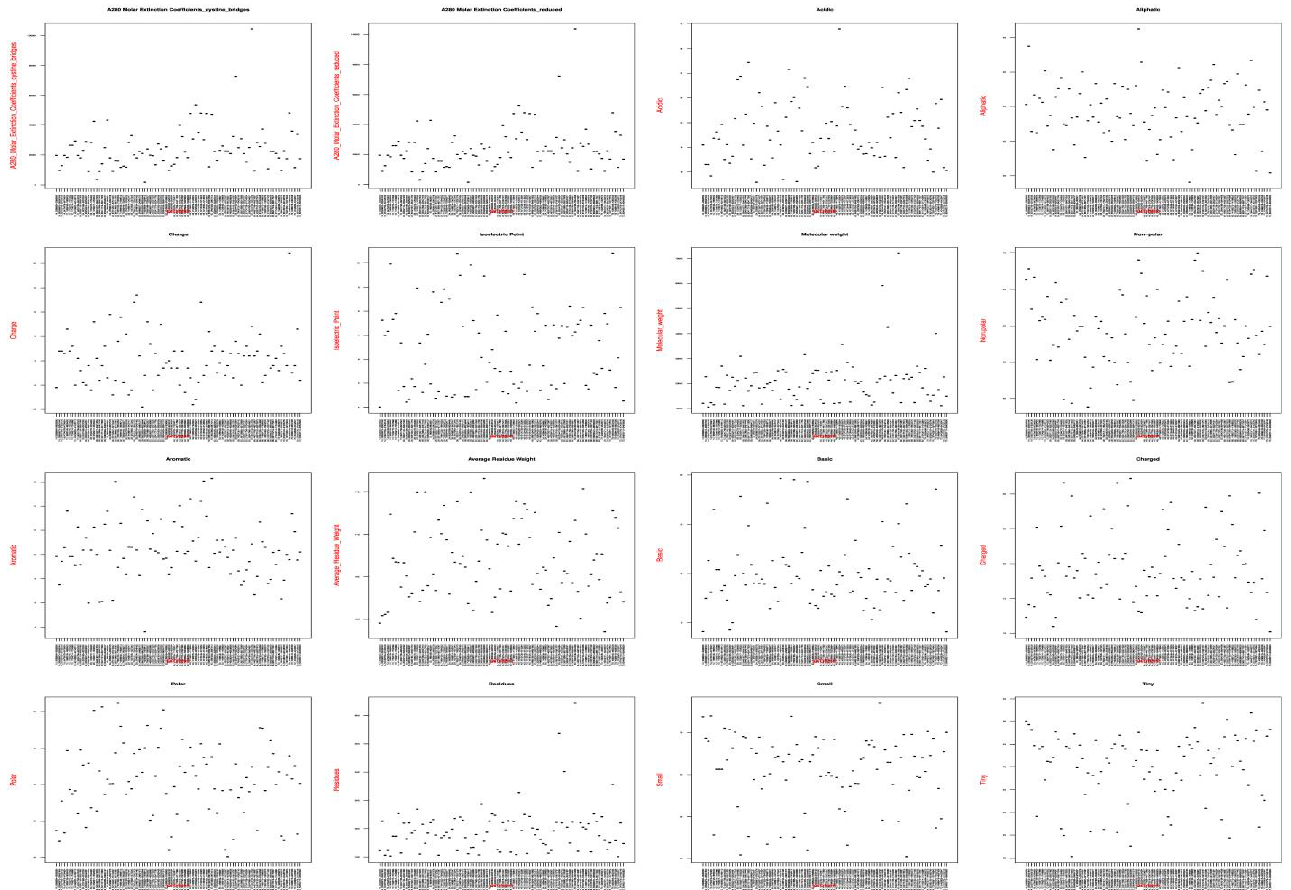
Figure 2: The protein chemical composition and physical properties for the predicated anti-fungal